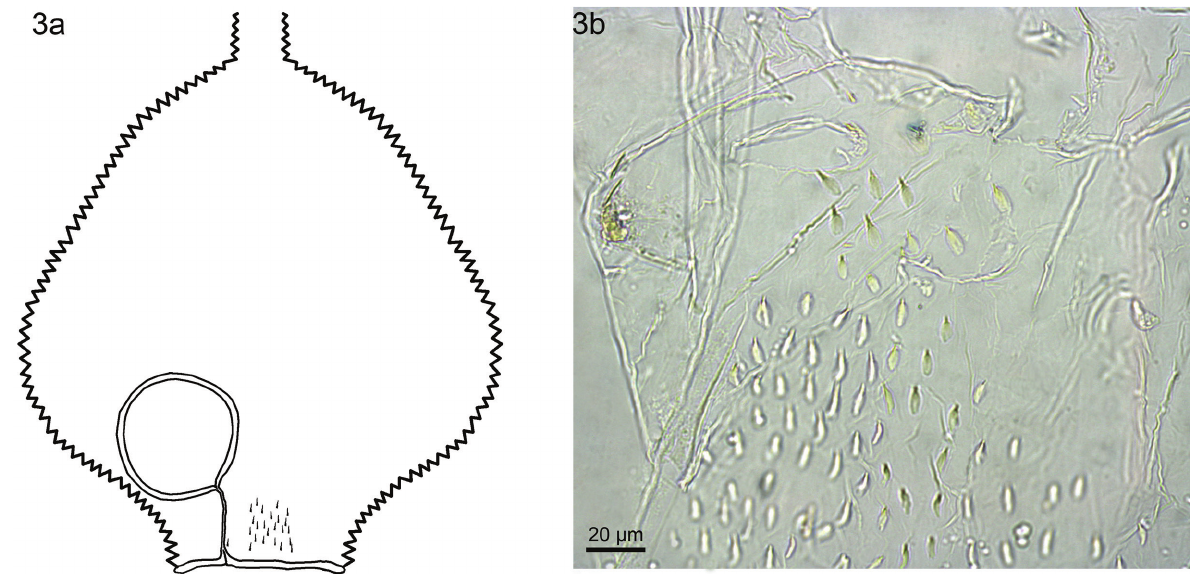
Figure 3. Cornitermes bolivianus . (a) Schematic drawing of P1 showing arrangement of spines; (b) Photomicrograph showing detail of spines with sclerotized bases.